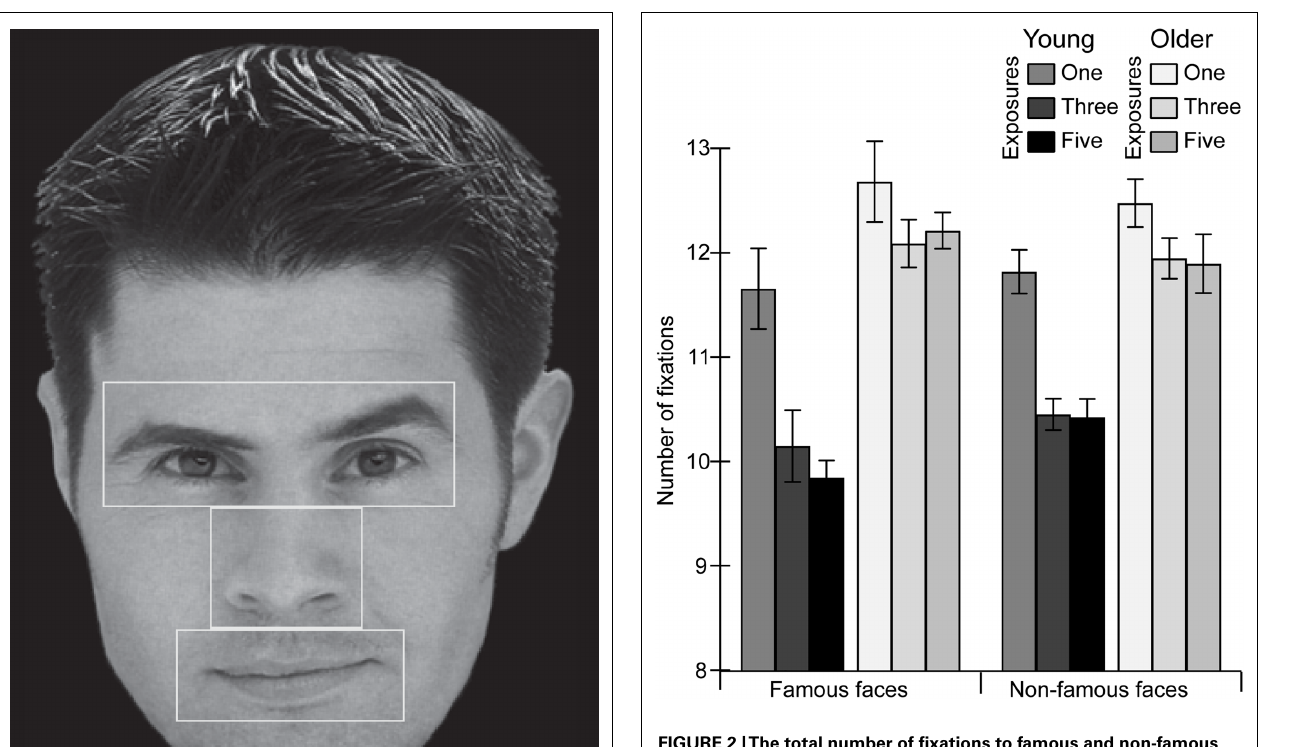
not between three versus five exposures ( p = 0.5). The